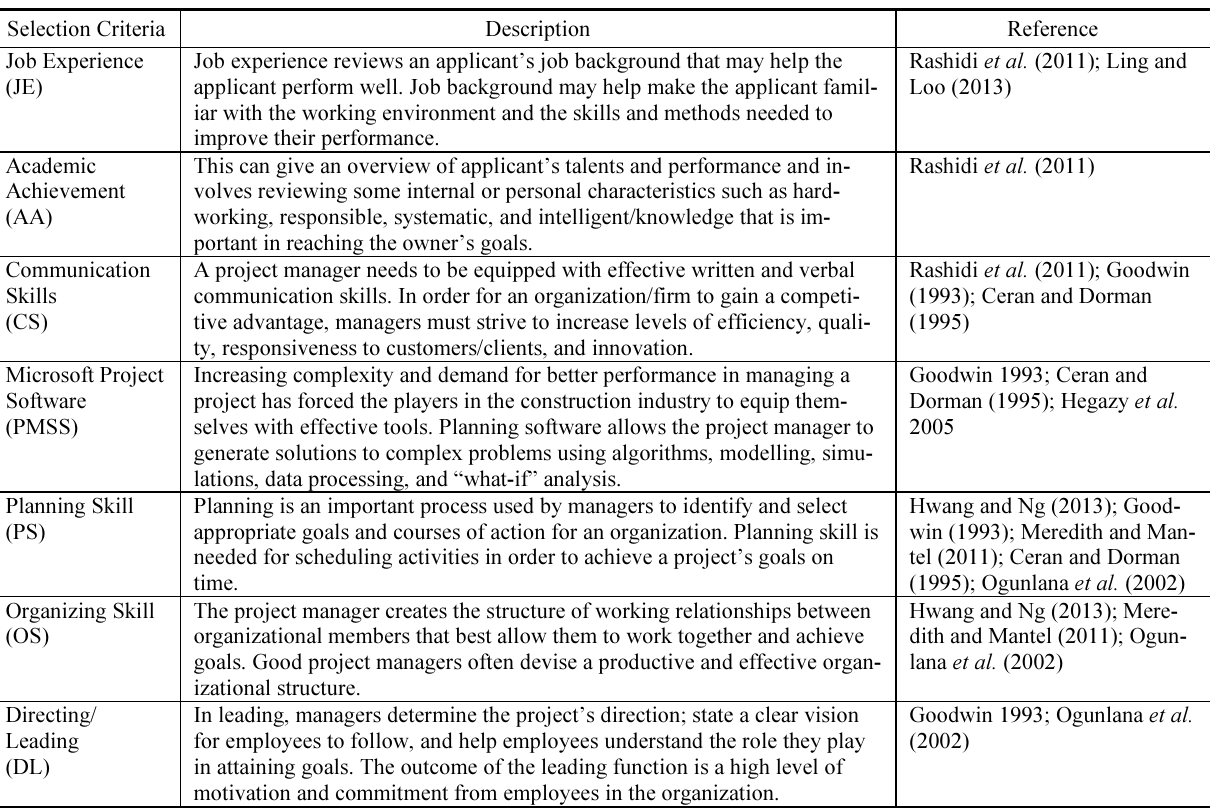
Table 2. Selection